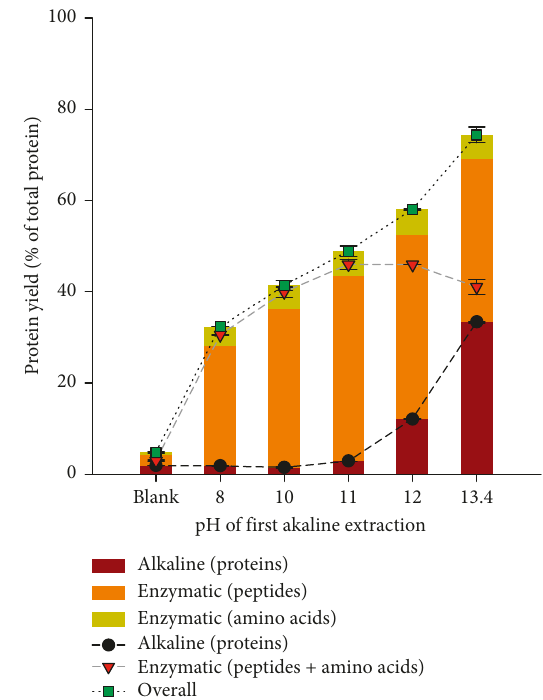
Figure 1: Effect of the pH of the first alkaline extraction on protein extraction yield (% of total protein) differencing among the two sequential alkaline and enzymatic extractions. The stacked bars represent the partial results obtained in the first alkaline extraction (proteins) and the second enzymatic extraction (differencing among peptides and amino acids). The lines represent the tendency of the same partial results and